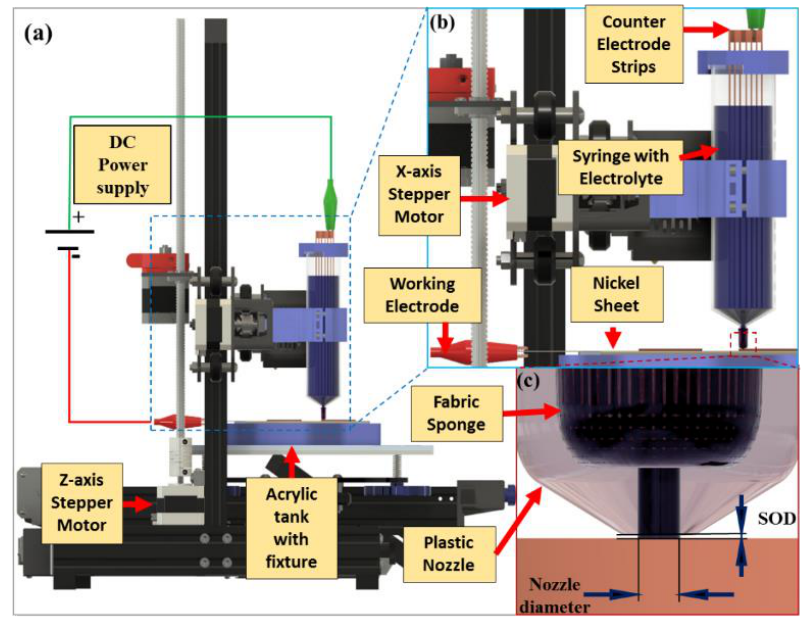
Figure 19. Development of lab-scale ECAM ( a ) setup, ( b ) syringe arrangement, and ( c ) nozzle tip [215].